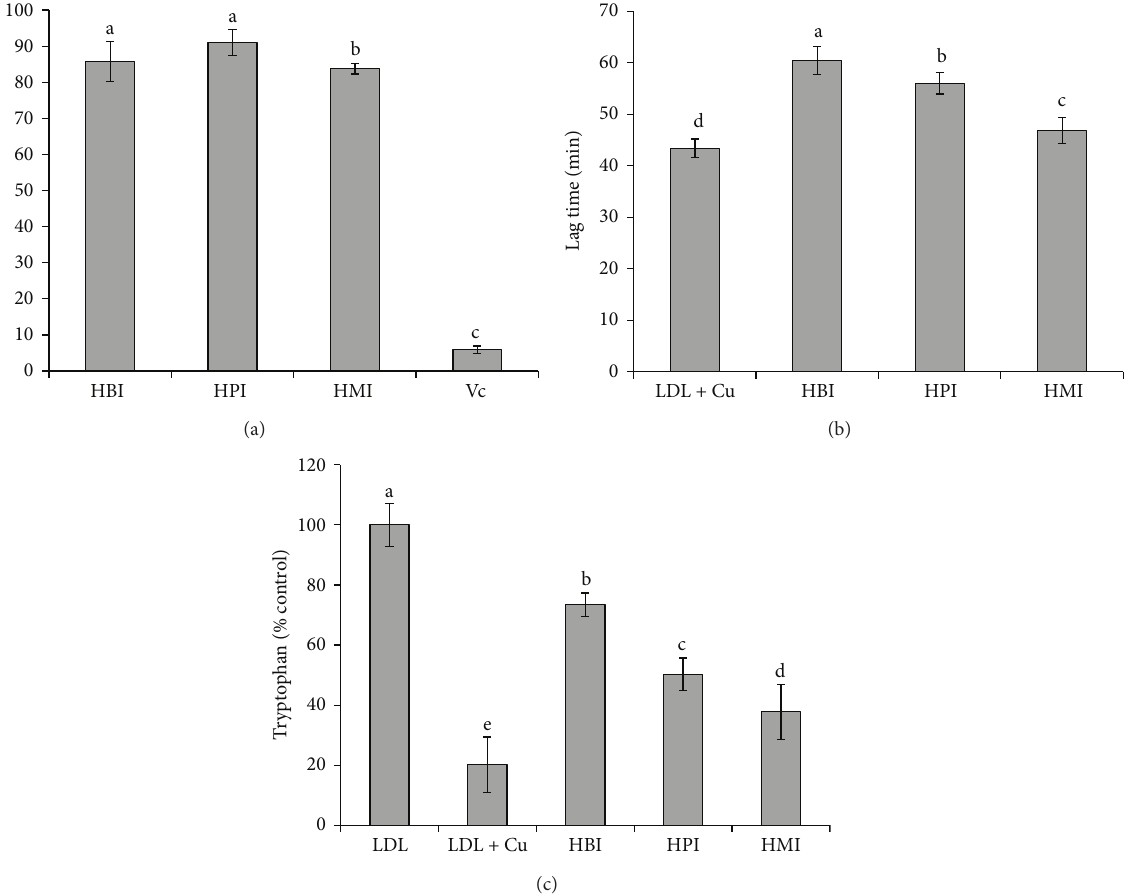
Figure 1: Effects of Hawk tea infusions on hemolysis of human erythrocytes (a); the lag time for formation of conjugated diene (b); and percentage of residual tryptophan fluorescence in LDL incubated in vitro (c). Each value is the mean ± SD; different letters (a, b, c, d, and e) show statistical significance (𝑃 < 0.05) .